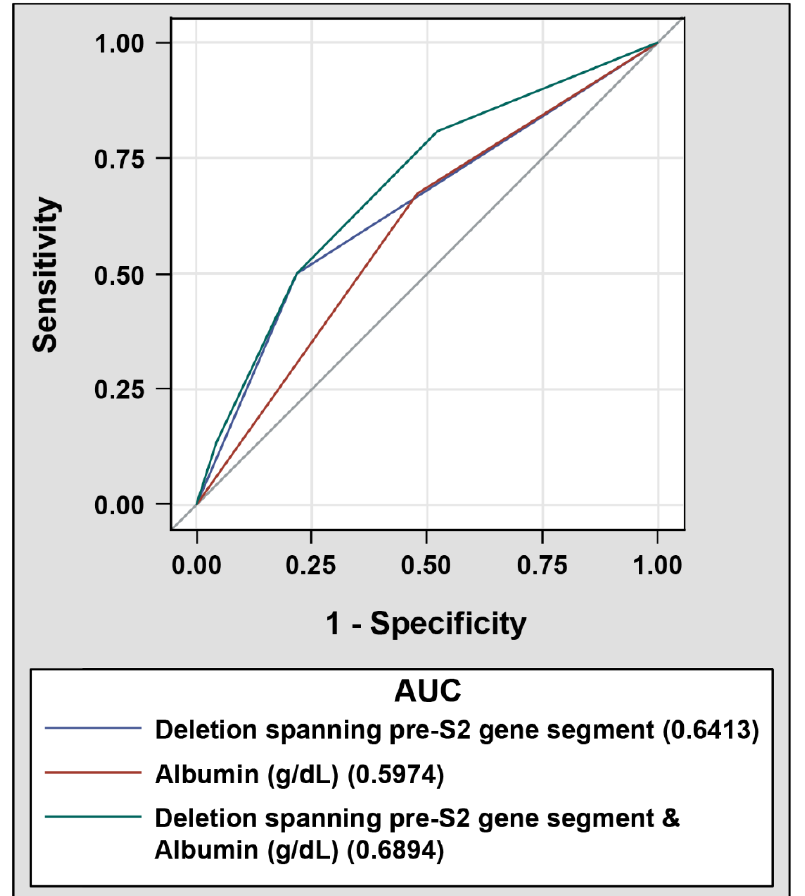
Table 5. Univariate recurrence-free survival analysis of patients with deletion spanning the pre-S2 gene segment and/or albumin. Characteristics HR 95% CI p Value Deletion spanning pre-S2 gene segment (presence vs. absence) 1.825 0.0307 * Albumin (g/dL) (>3.8 vs. ≤ 3.8) 0.515 0.0258 * Deletion spanning pre-S2 gene segment and Albumin (g/dL) (absence and ≤ 3.8 vs. absence and >3.8) Deletion spanning pre-S2 gene segment and Albumin (g/dL) (presence and >3.8 vs. absence and >3.8) and Albumin (g/dL) (presence and ≤ 3.8 vs. absence and >3.8)